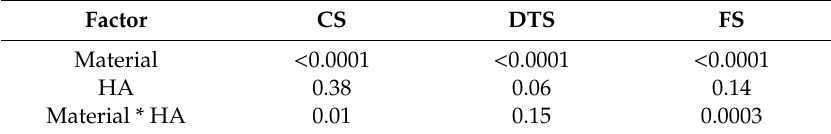
Table 4. Result of two-way ANOVA test.